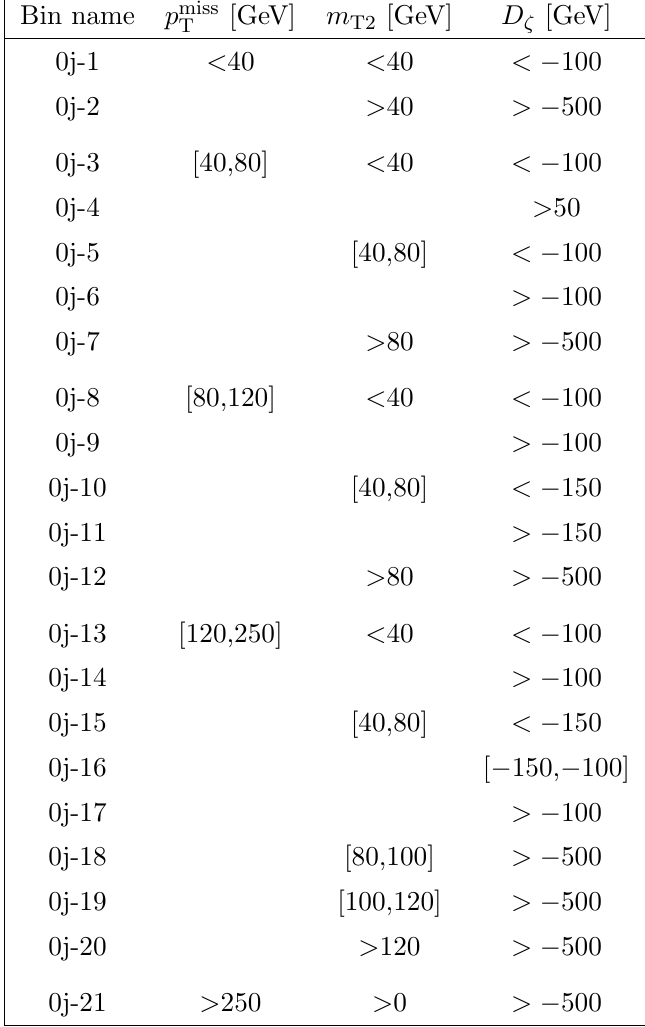
h and (cid:22)(cid:28) h (cid:12)nal states.